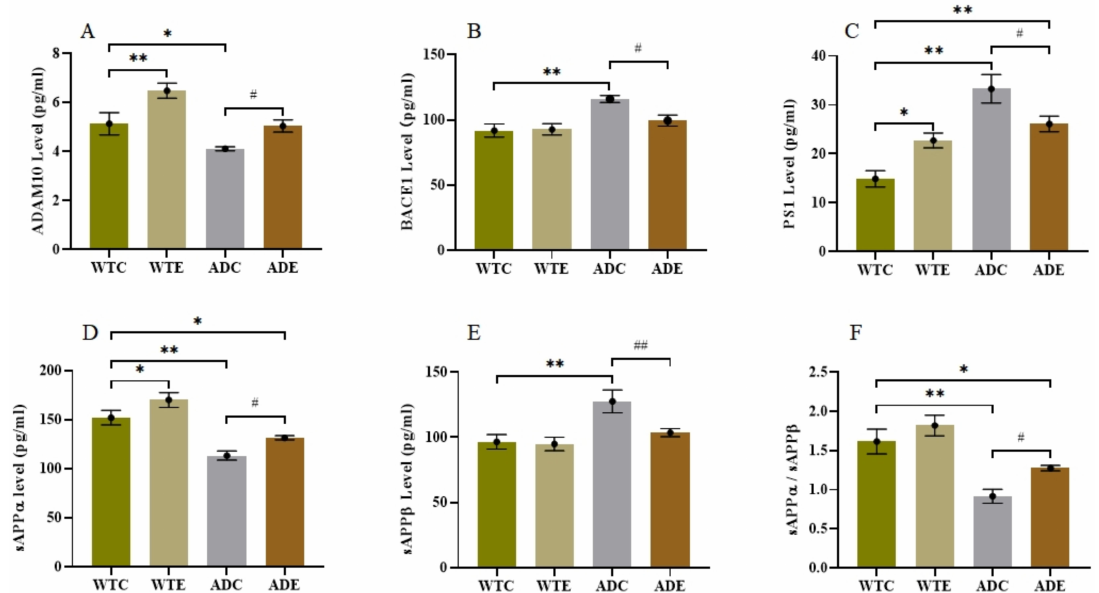
Figure 7. Effect of treadmill exercise on various secretase levels and APP metabolite production in mice. ( A ) ADAM10 levels in the hippocampus. ( B ) BACE1 levels in the hippocampus. ( C ) PS1 levels in the hippocampus. ( D ) sAPP α levels in the hippocampus. ( E ) sAPP β levels in the hippocampus. ( F ) sAPP α /sAPP β ratio. n = 6 for each group. * p < 0.05, ** p < 0.01 compared with WTC. # p < 0.05, ## p < 0.01 compared with